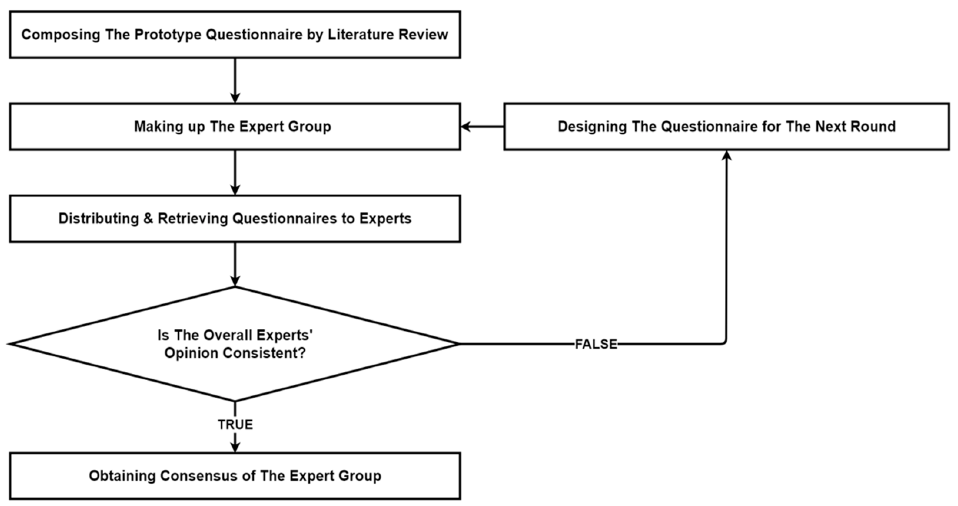
Figure 3. Modified Delphi Method steps [41].